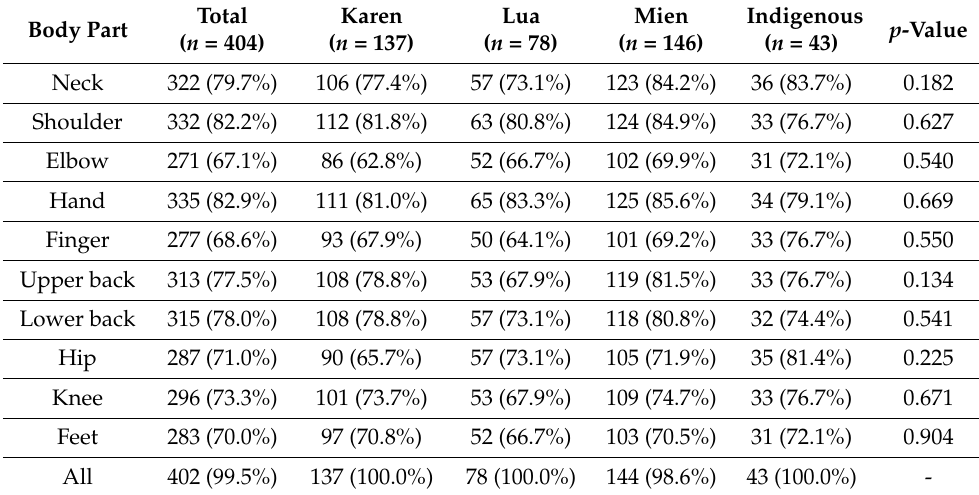
Table 3. Comparison of MSD prevalence in body regions during the past 7 days of work among ethnic worker groups.